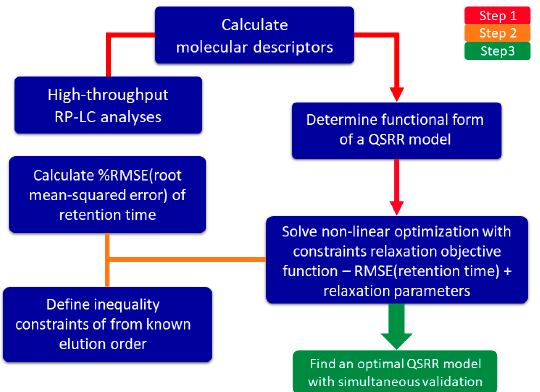
Figure 1. Schematic depiction of the non-linear programming (NLP)-based elution order prediction methodology. Abbreviations (in order of appearance): RP-LC—reversed-phase liquid chromatography, RMSE—root mean square error, QSRR—quantitative structure-retention relationships.